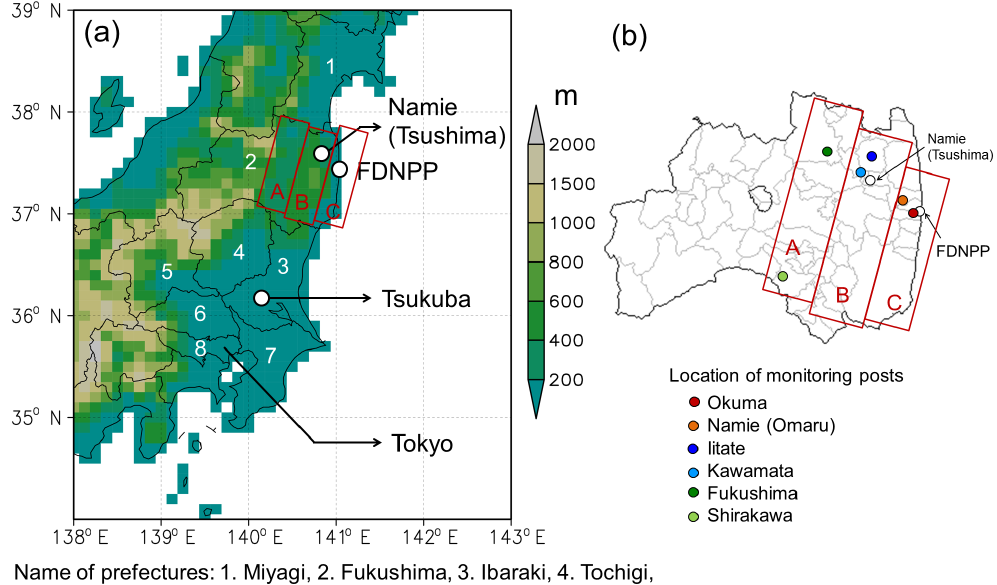
Figure 1. (a) The model domain showing the model terrestrial elevation, observation sites, and other locations described in the study. The linear distances from FDNPP to Namie (Tsushima district, town of Namie), Tsukuba and Tokyo are approximately 30, 170, and 220km, respectively. The numbers denote prefectures: 1, Miyagi; 2, Fukushima; 3, Ibaraki; 4, Tochigi; 5, Gunma; 6, Saitama; 7, Chiba; and 8, Tokyo. (b) Fukushima prefecture and (colored circles) the locations (village, town, or city name) of monitoring posts used in this study (see Fig. 14). The red letters in both (a) and (b) denote the name of the area based on geographical features: A, Nakadori valley; B, Abukuma highland; and C, Hamadori coastal